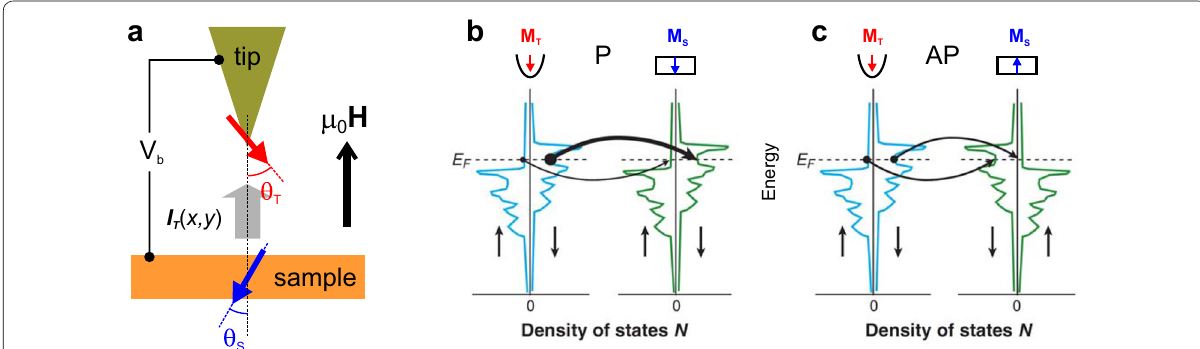
Fig. 1 Tunneling in spin‑polarized scanning tunneling microscopy. a A schematic illustration of the tunneling current between a magnetic sample and a magnetic tip in scanning tunneling microscopy (STM) in an external magnetic field μ 0 H . b , c A simplified picture of spin‑polarized tunneling within a hypothetical spin‑split density of states model in parallel ( P ) and antiparallel ( AP ) magnetization orientations. The spin orientation of the tunneling electrons is assumed to be conserved during tunneling, i.e., spin‑up electrons always tunnel into spin‑up states and spin‑down electrons always tunnel into spin‑down states. Arrows ( bottom ) indicate the DOS of spin‑up and spin‑down electrons. The spin direction is antiparallel to the magnetic moment [64]. M T and M S ( top arrows ) denote the magnetization orientation of tip and sample, respectively. b P and c AP alignment of tip and sample magnetization (Reprinted from [4] with permission from American Physical Society (Copyright